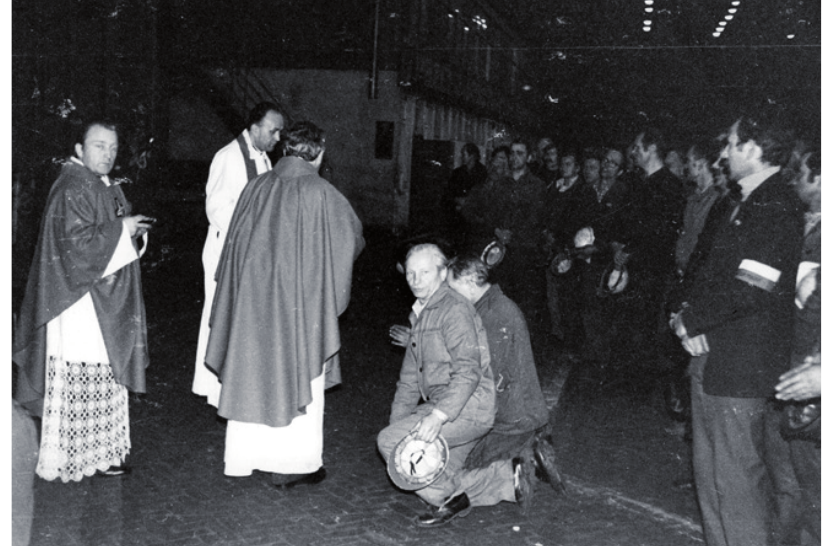
Fig. 2. A mass during the strike in the Car Body Sheet Mill of HiL on the 13 XII 1981 celebrated by Jan Biela ń ski and Józef Biela ń ski; photo, Józef